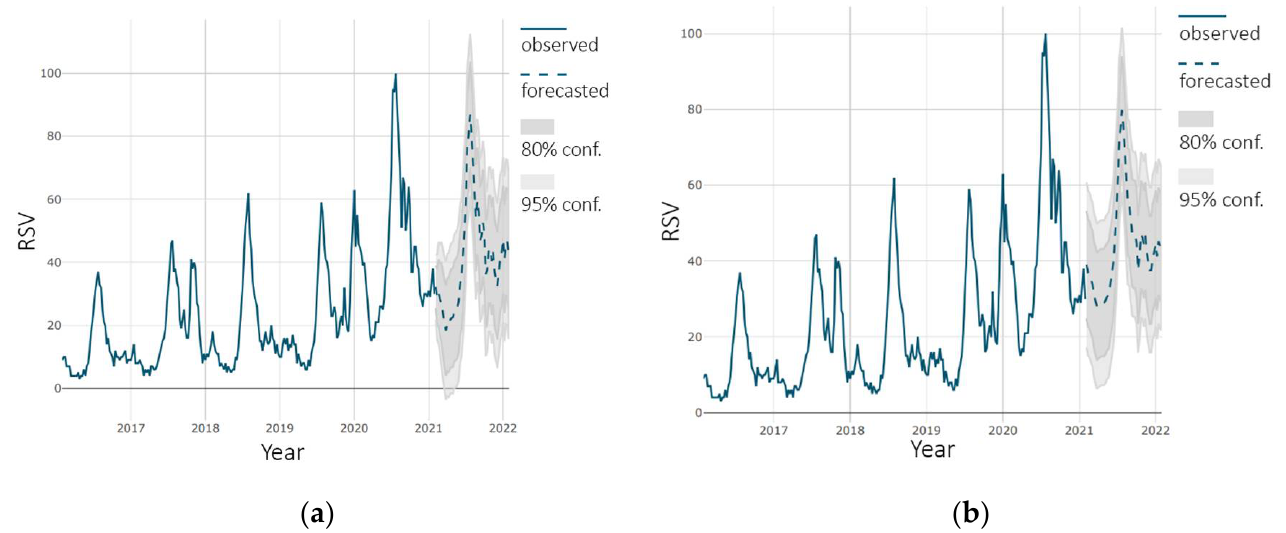
Figure 4. Forecast of interest in “flu” vaccine: ( a ) using SARIMA model; ( b ) using tslm model. The prediction for the HPV vaccine is shown in Figure 5a. According to the figure, the level of interest in the vaccine at the end of the forecast period is at the same level as at the beginning of 2021 (the difference is within the boundaries of statistical error).